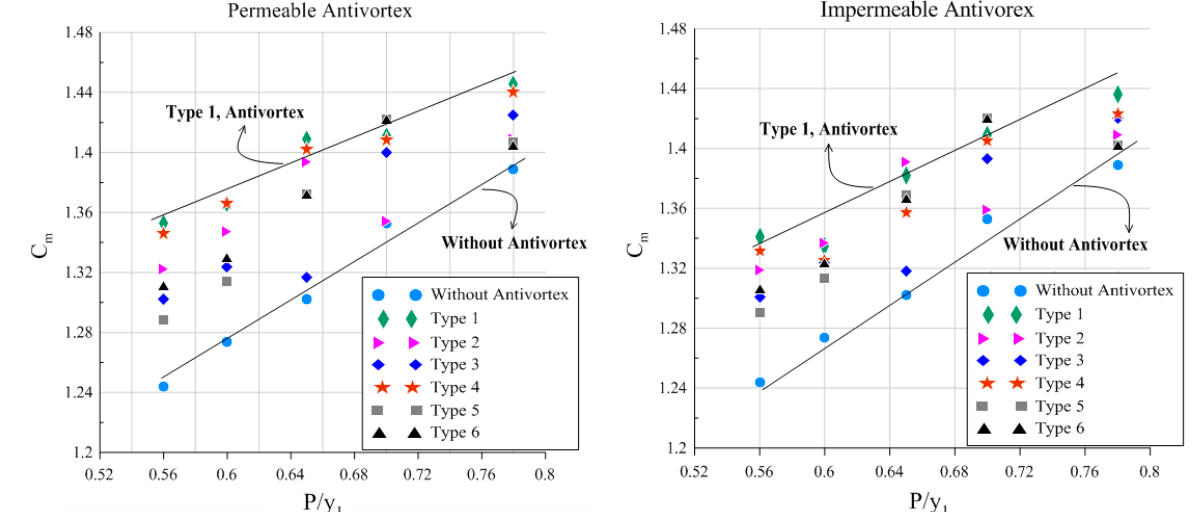
Figure 12. Variations in C d with P/y 1 for the triangular labyrinth side weir with permeable and impermeable antivortexes.